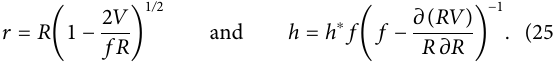
horizontal cross section from the bottom panel gives the corresponding V ( R ) for that same Rankine vortex. Since all the effects of radial advection are implicit in the R -coordinate, these often striking radial advective effects appear in the transformation back from R to r , i.e., in going from the bottom panel to the top panel in Figure6. Someofthe informationin Figure6 canalsobepresentedin tabular form, as shown in Table 3. In constructing Table 3 we have chosen R 0 = 300 km and a convenient set of values for v 0 , and then used Eq. 20 to determine r 0 and V 0 . The determination of r 0 is easily accomplished by noting that the two equations in Eq. 20 can be combined into r 0 (cid:2) [( α 2 + 1 ) 1/2 − α ] R 0 , where α = v 0 /( fR 0 ). Once r 0 is thereby found, V 0 can be computed from V 0 = ( r 0 / R 0 ) v 0 . Table 3 shows properties for a sequence of Rankine vortices with R 0 = 300 km, running from tropical depression (TD), to tropical storm (TS), and on upward to category fi ve hurricane strength.